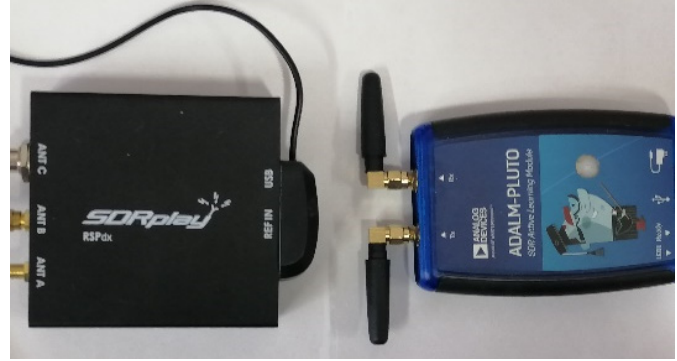
Figure 2. The SDR devices used in the experiment.